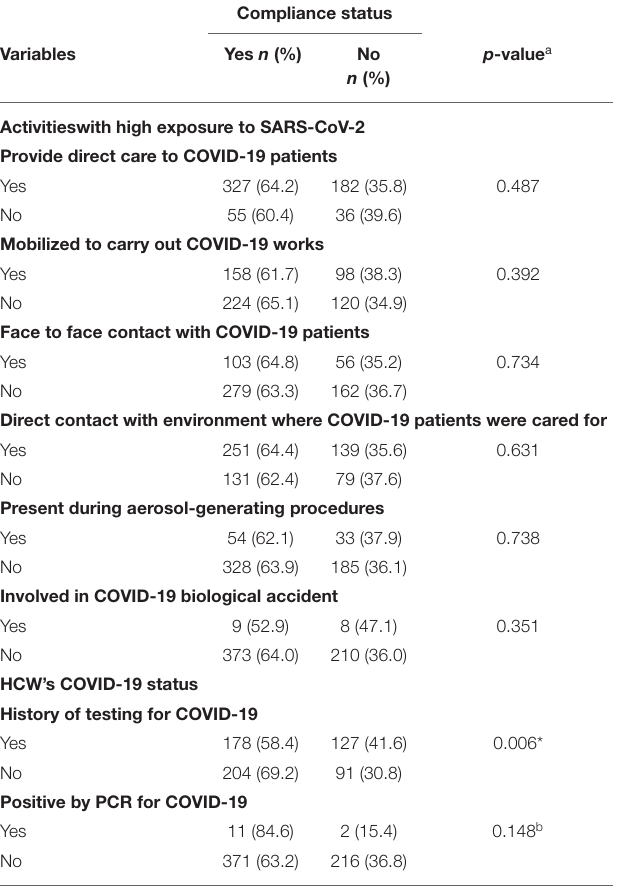
TABLE 2 | Activities with high exposure to SARS-CoV-2 and COVID-19 status according to IPC compliance